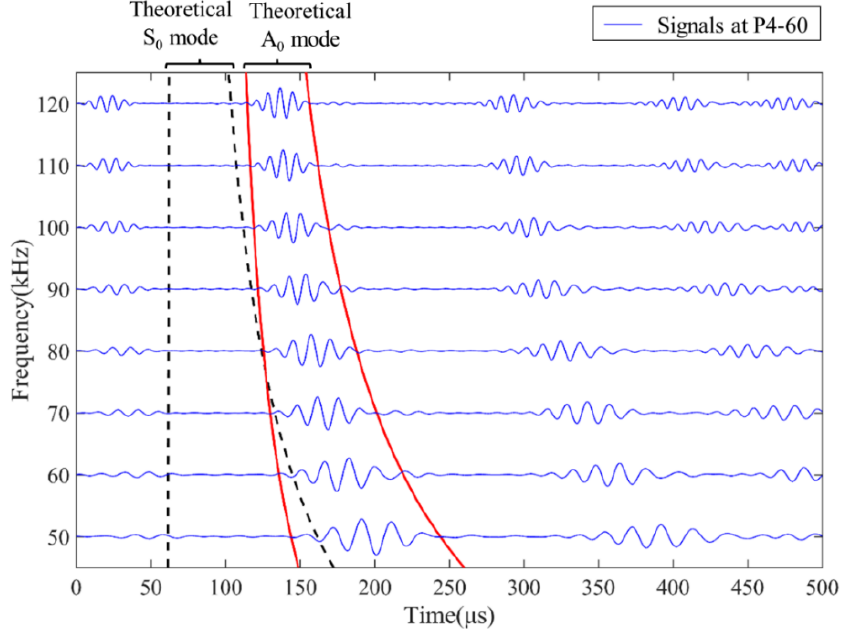
Figure 7. Comparison of theoretical and experimental arrival times of Lamb wave signals at different frequencies.